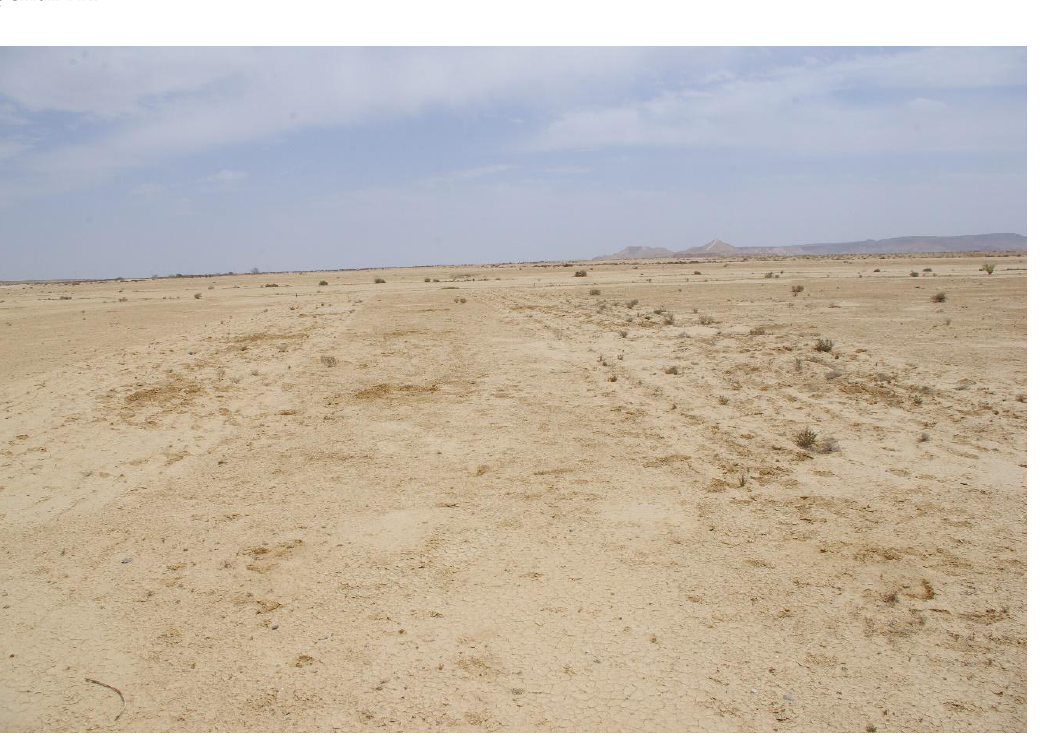
Figure A1. Research block, with deep chiseling treatment plot on the right side, shallow chiseling treatment plot on the left side, and a control plot in the middle. Note the greatest surface roughness on the right, intermediate roughness on the left, and smallest roughness in the middle. Photographed by I. Stavi in April 2017, three years after the plots were